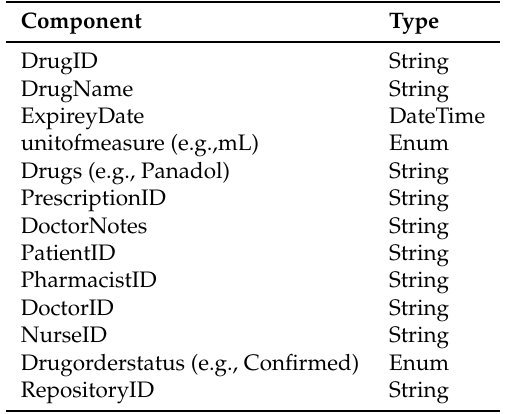
Table 3. Drug supply chain management definition in a medical blockchain.